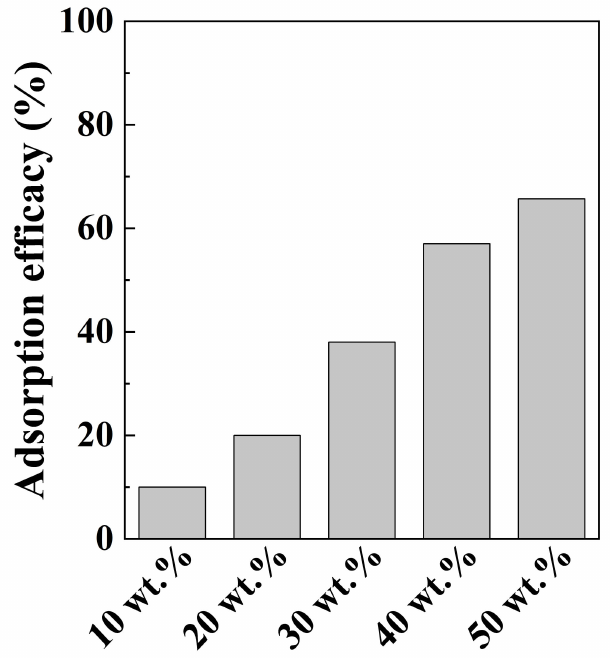
Figure 5. The chromate adsorption efficacies of LDH–BT_SP with various amounts (wt.%) of LDH (initial chromate concentration = 10 mg/L; adsorbent concentration = 1 g/L; contract time = 2